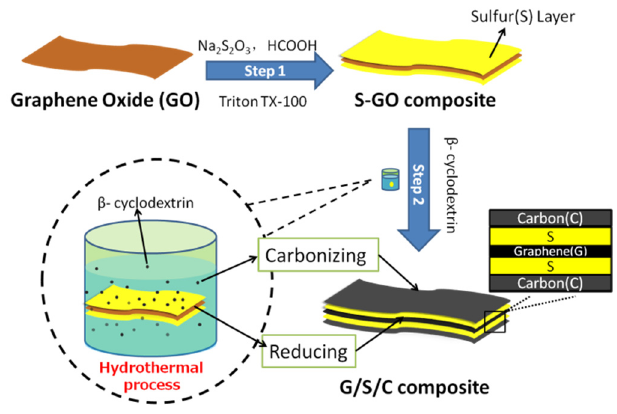
Figure 1. Schematic of synthesis steps for G/S/C composite and a proposed structure of the